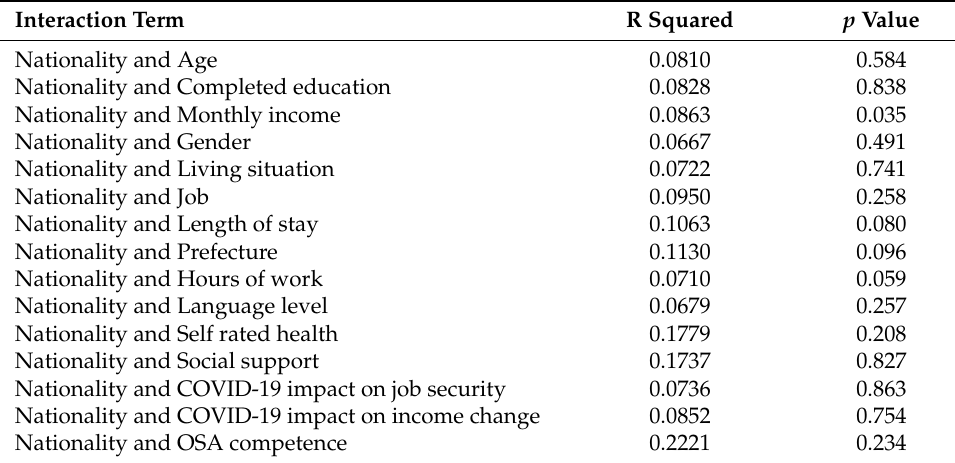
Table A2. Interaction Term